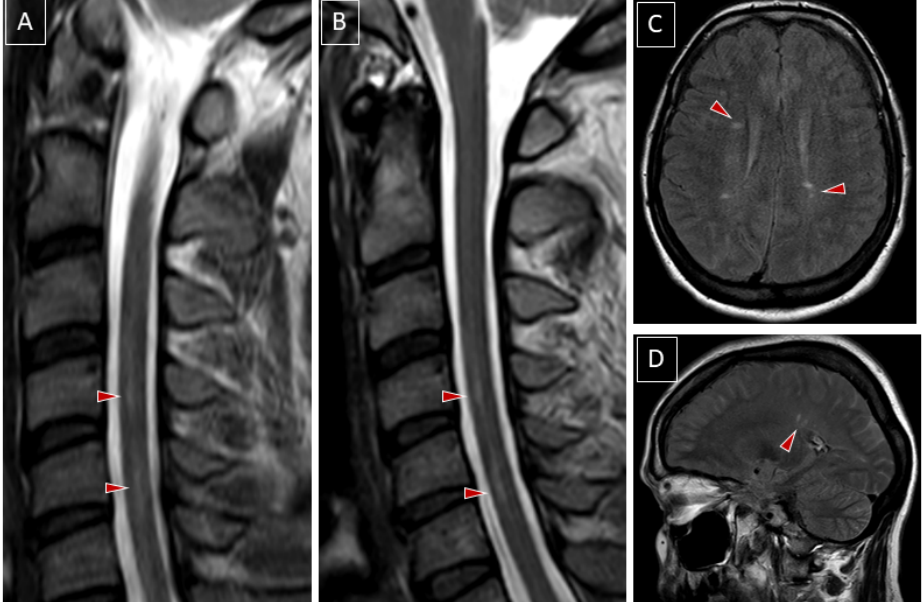
Figure 1. Radiological features of longitudinally extensive myelitis related to the tick-borne encephalitis virus (TBEV) which caused a Polio-like illness. Panel ( A ). Spinal cord MRI T2 sagittal images in the acute phase. The presence of a tractopathy involving the central and anterior section of the cervical spinal cord which expands over more than three vertebral bodies is depicted by red arrows. Panel ( B ). A follow-up scan one month later demonstrates a slight reduction of the hyperintense signal, shown by the red arrows. Panels ( C , D ). Fluid-attenuated Inversion recovery (FLAIR) MRI (axial and sagittal planes) revealed several oval-shaped hyperintensities perpendicular to the ventricle system, consistent with white-matter disease, shown by the red arrows.